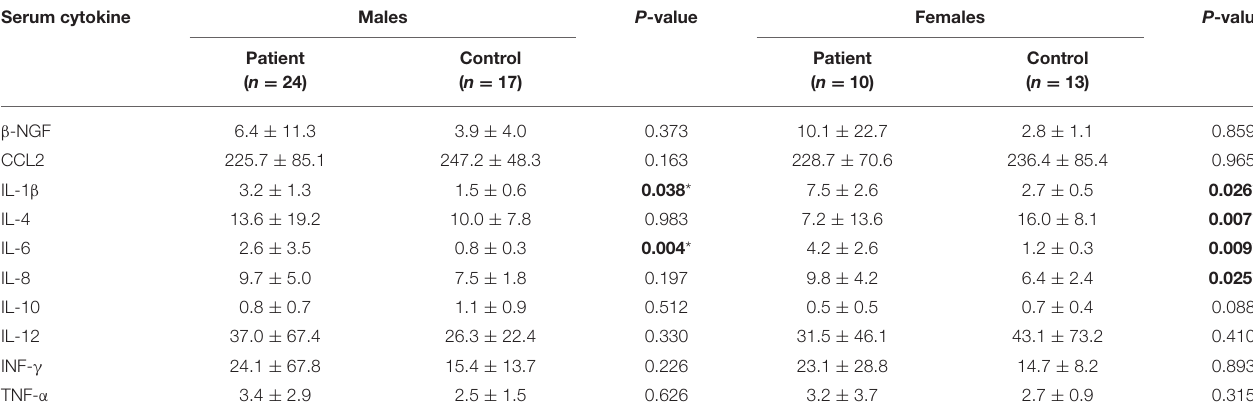
TABLE 3 | MTBI inflammatory cytokines detection outcomes in patients with mTBI and healthy controls. Serum cytokine